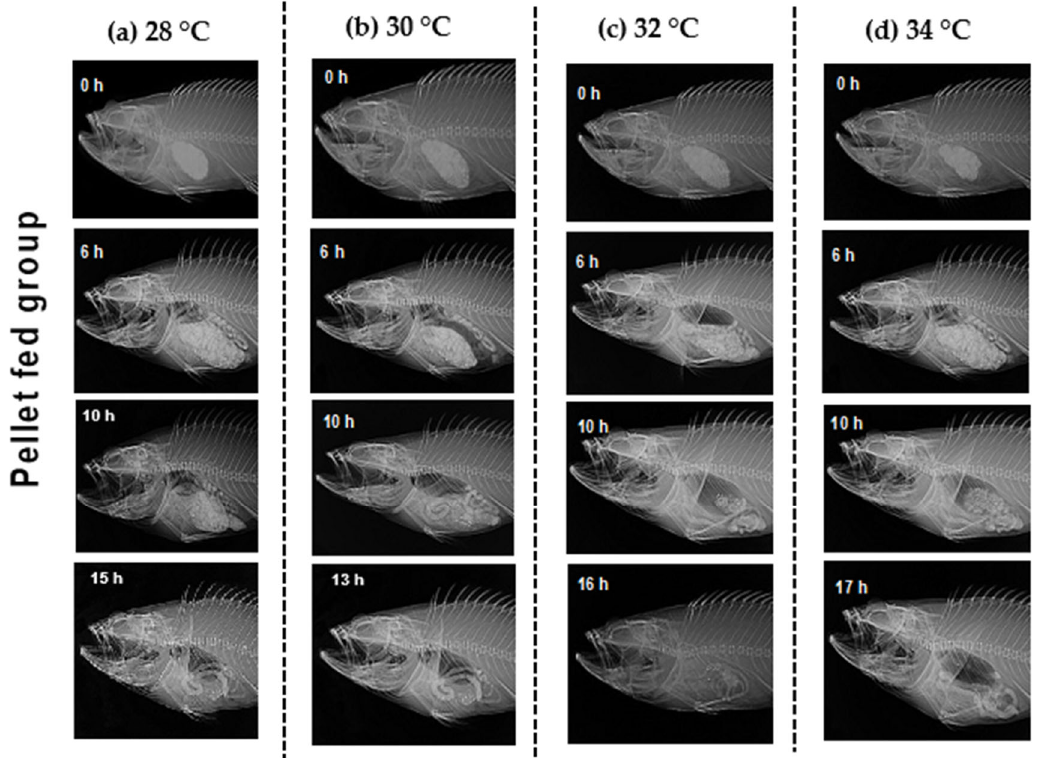
Figure 5. Movement of radio ‐ opaque barium sulphate (BaSO 4 ) along the alimentary tract of the adult hybrid Sabah grouper. Each panel shows the passage of ingested BaSO 4 ‐ treated pelleted food through the alimentary tract of the hybrid Sabah group at ( a ) 28 C, ( b ) 30 C, ( c ) 32 C, and ( d ) 34 C. Five fish were used for each sampling point and temperature. Only X ‐ ray images with notable movement along the tract are shown.